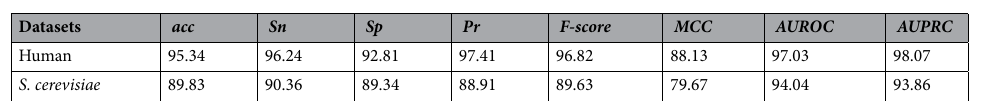
Table 7. The results of designed baselines using LSTM-based LM features for PPI datasets.